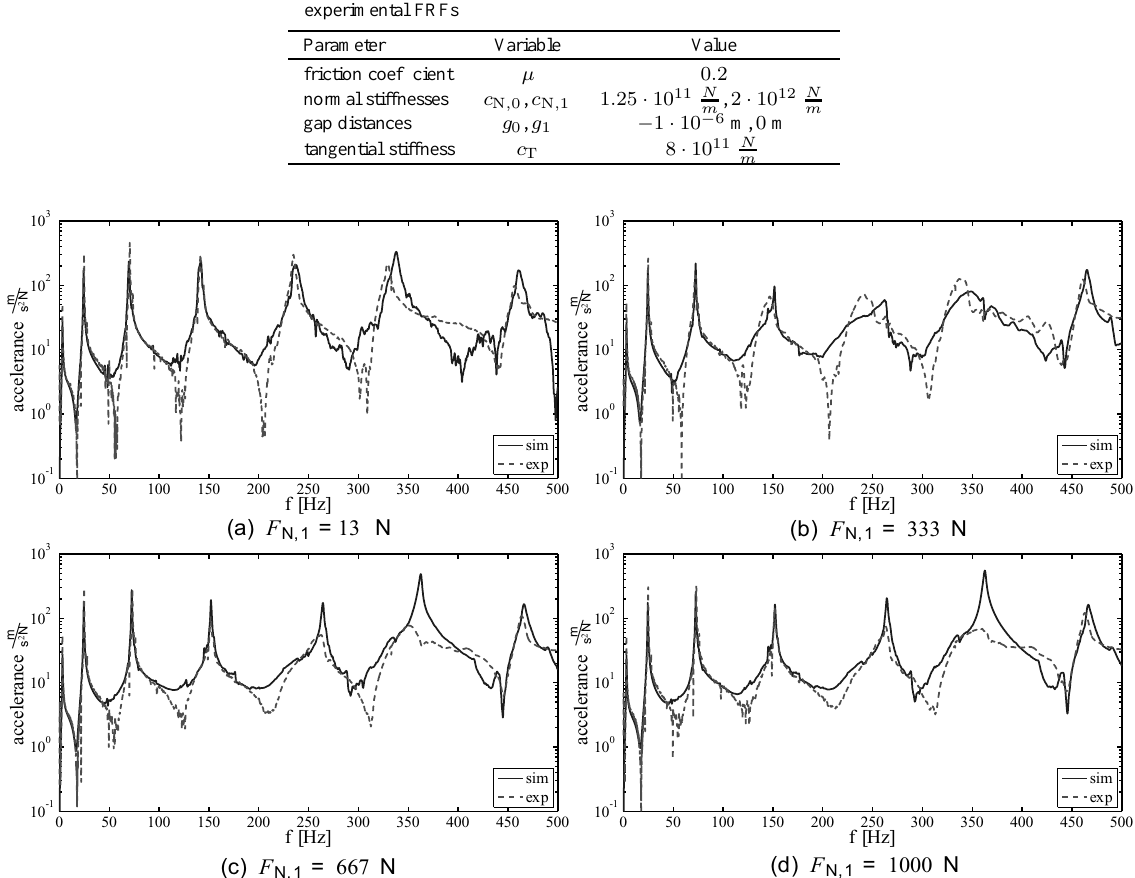
Fig. 11. Comparison of measured and simulated FRFs for with varied friction coefficient µ =